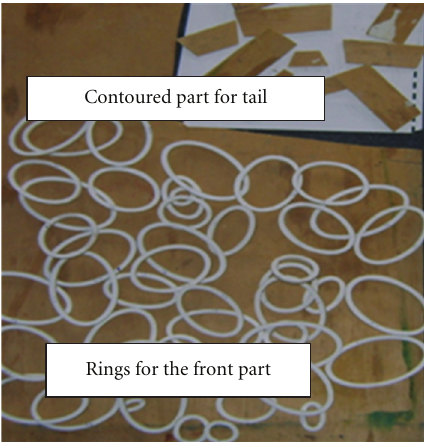
Figure 9: The tracing is translated into ring for the front part and contoured section for the rear part.